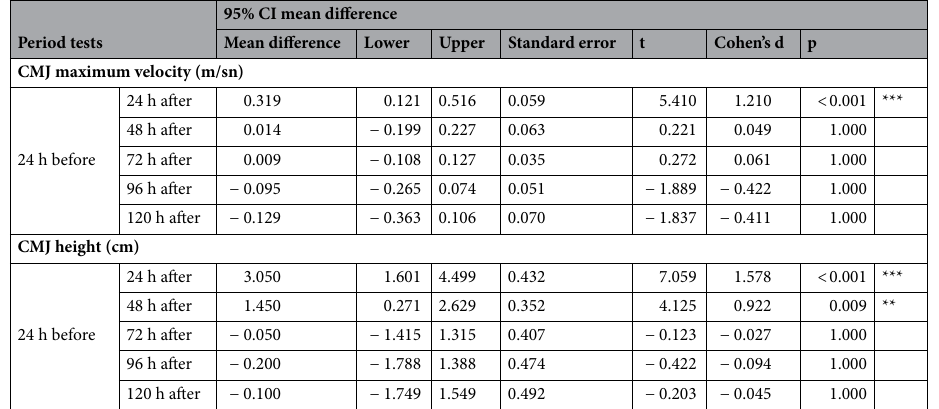
Table 2. Post Hoc comparisons—CMJ maximum velocity (m/sn) and CMJ height (cm). ***p < 0.001, **p <